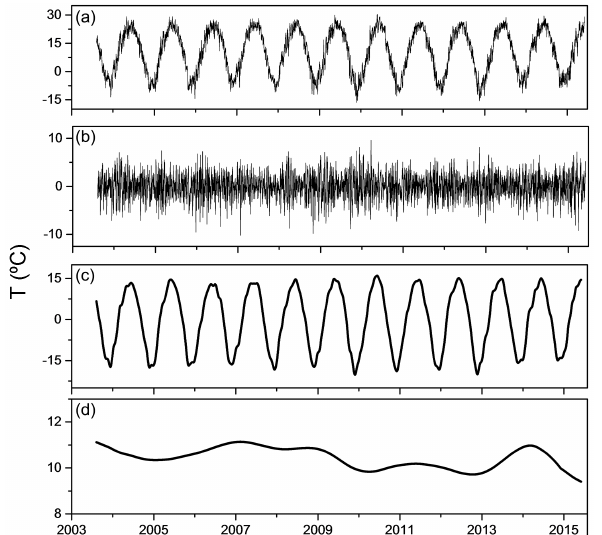
Figure 4. Separated time series of daily mean values of tempera- ture at SDZ: (a) the original data; (b) the short-term component, W(t) ; (c) the seasonal component, S(t) ; (d) the long-term compo- nent, e(t) .